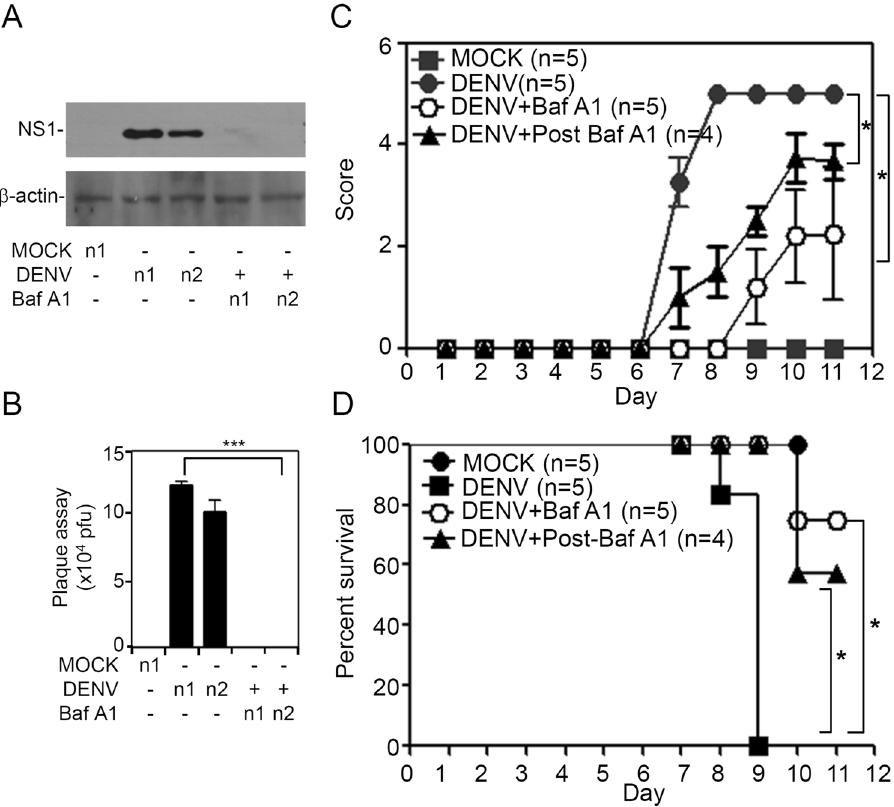
Figure 6. Inhibiting endosomal acidification increases the survival rate in suckling mice during dengue virus (DENV) infection. Seven-day-old ICR suckling mice were inoculated with DENV2 by concurrent intracranial and intraperitoneal injections with or without bafilomycin A1 (BafA1; 1 mg/kg) co-treatment or post-treatment. ( A ) Western blot analysis of viral NS1 or NS4B protein expression and ( B ) plaque assays of DENV replication in the brain of ICR suckling mice at 7 days post-infection. Values are presented as the mean ± SD ( n = 4~7). *** p < 0.001. Additionally, time-kinetic changes in clinical scores ( C ) and survival rates ( D ) were measured ( n = 4 or 5). * p <